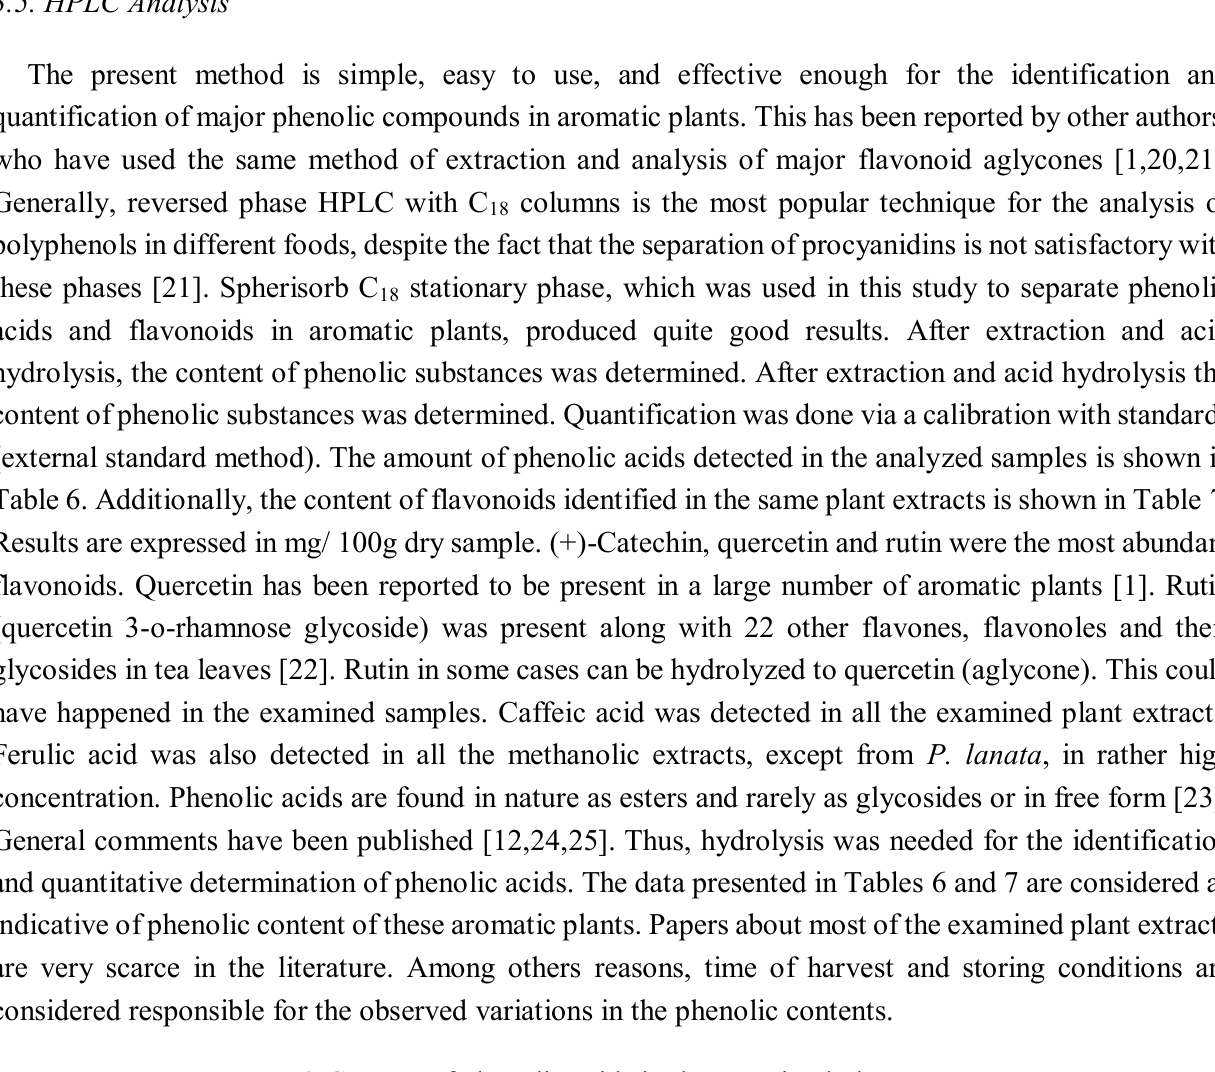
Table 6. Content of phenolic acids in the examined plant